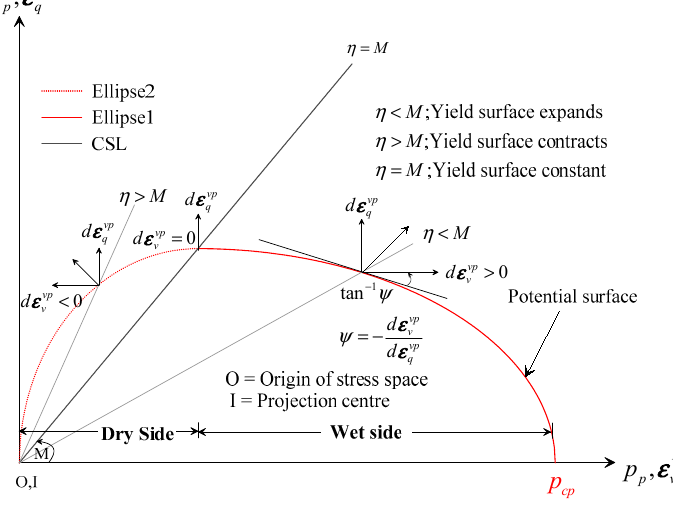
Figure 3. Meridional section of the potential surface with ellipse 1 and ellipse 2.